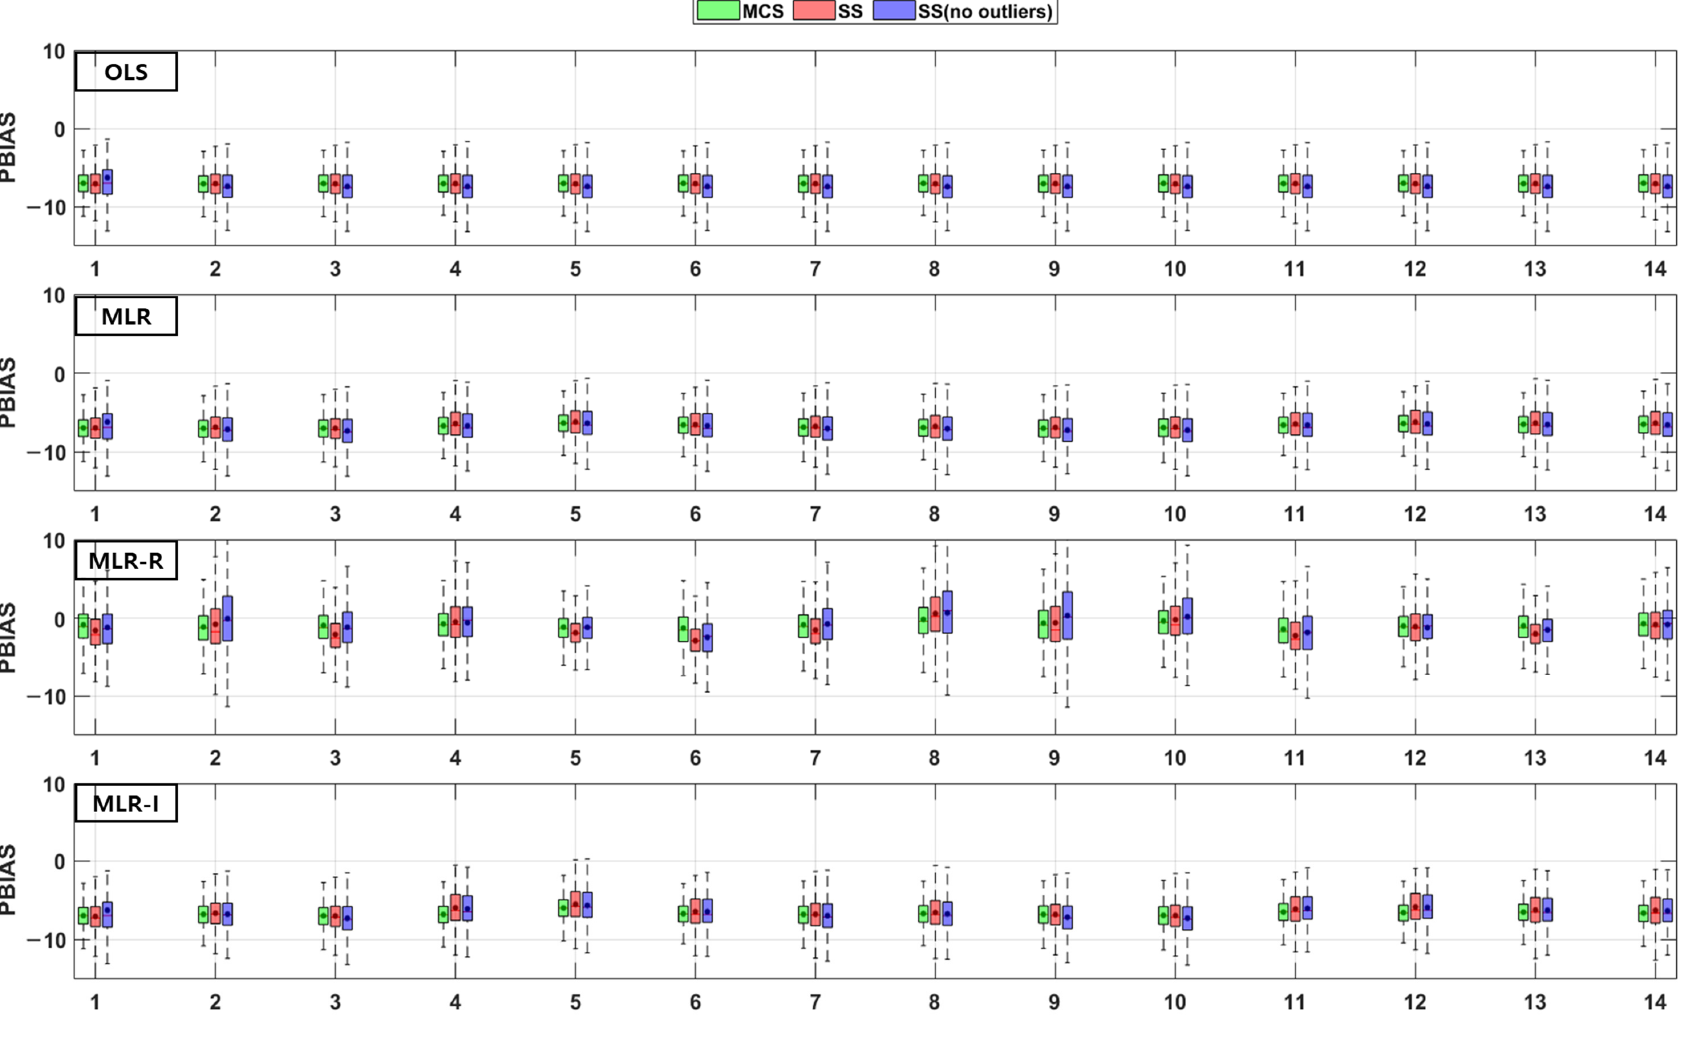
Figure 7. Error analysis (PBIAS) results of TP removal in detention basins.